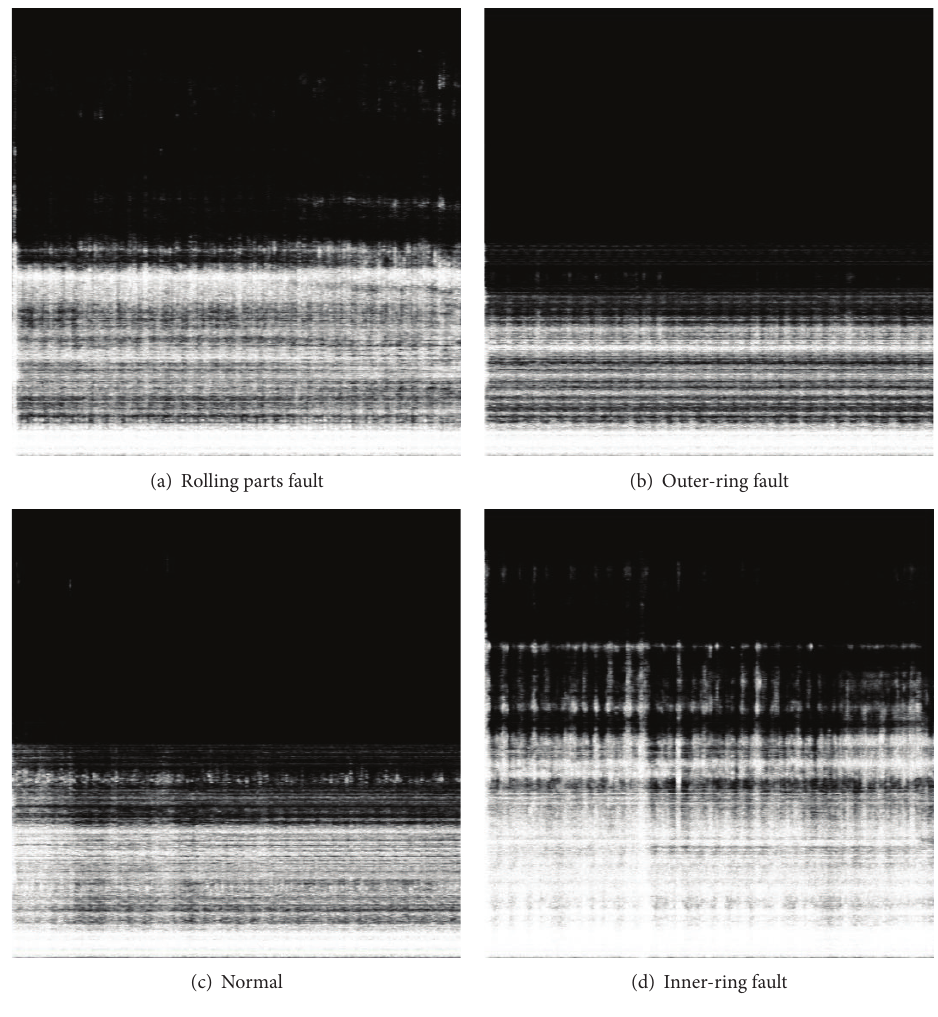
Figure 14: Gray images of four fault modes.